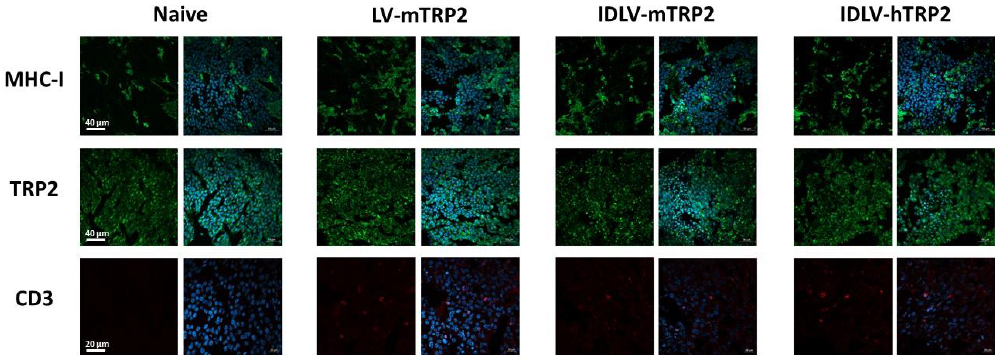
Figure 9. Confocal laser scanning microscopy (CLSM) analyses on mice tissue sections. Representative images of tumor from naïve, LV-mTRP2, IDLV-mTRP2, and IDLV-hTRP2 mice are shown. Tissue sections 8 µm thick were stained for MHC–I (green), TRP2 (green), or CD3 (red) as indicated (left columns) and for DAPI as nuclear staining (blue, right columns). Images represent a 3D reconstruction of 30–40 single Z-stack. Results from one representative experiment are shown for each analysis. Scale bars are indicated.